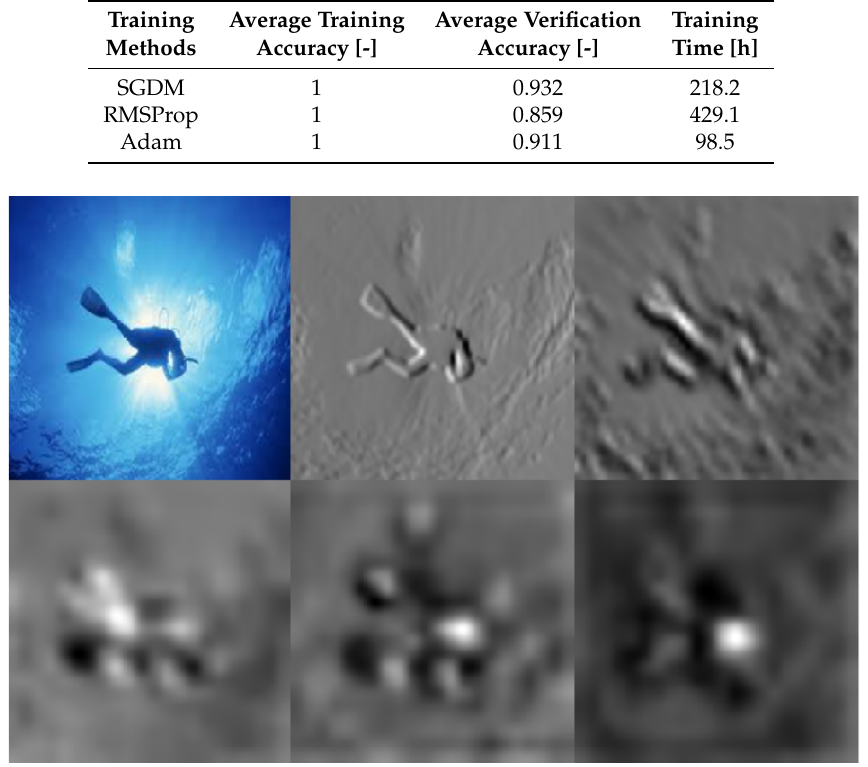
Figure 9. Diver wrongly classified as a fish (from top right to bottom left): source image, proccessed images in grey on the following layer outputs of DLNN: conv1, conv2, conv3, conv4 and conv5.